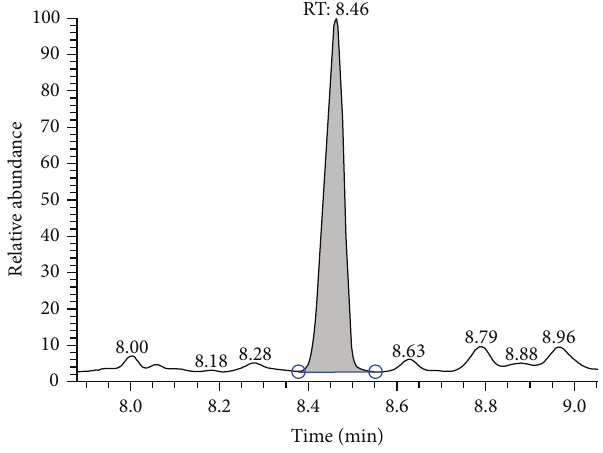
Figure 4: Spectra showing octadecanoic acid separated at retention time of 8.46 min.